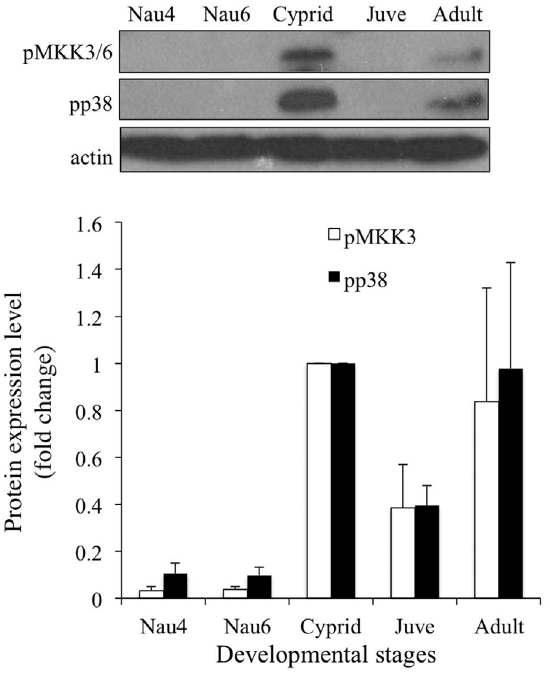
Figure 6. pMKK3 and pp38MAPK patterns were similar during development of Amphibalanusamphitrite . Equal amounts of total protein extracts (100 m g) from each developmental stage were blotted with antibodies against pMKK3 and pp38MAPK. A representative image is shown. Levels of pp38MAPK and pMKK3 in cyprid stage were normalized to a unit of 1 for relative comparison with other stages. Multiple comparison analysis showed that levels of MKK3 and p38MAPK phosphorylation were significantly elevated at cyprid stage, compared to nauplii IV, VI and juvenile stages. The levels of pMKK3 and pp38MAPK in adults did not reveal difference from those of other stages. Nau 4: stage IV Nauplii; Nau 6: stage VI Nauplii; Juve: juveniles collected 1 day after metamorphosis.